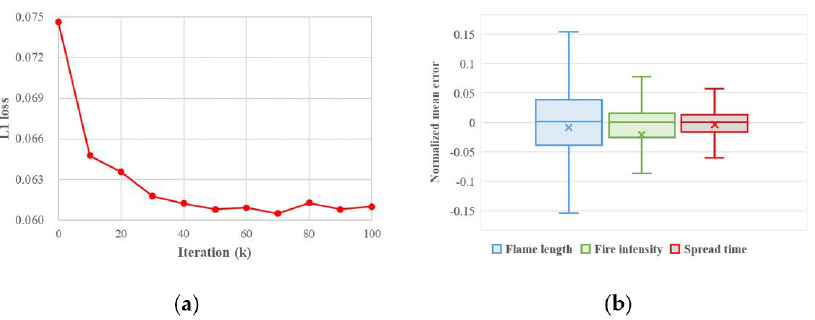
Figure 6. Performance of WFDNN . ( a ) Training curve; ( b ) test